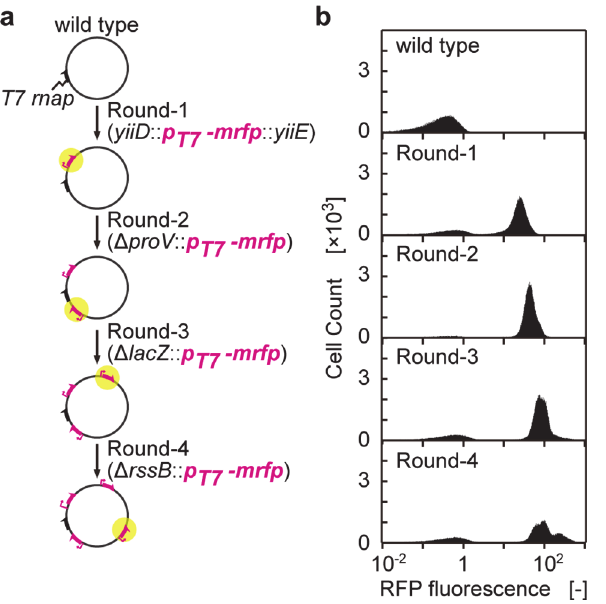
Fig 5. Sequential replacement of four chromosomal loci with DNA fragments encoding p T7 - mrfp . (a) The production flow chart for four-round gene replacement. (b) Flow cytometric analysis of the recombinant pool after each round of